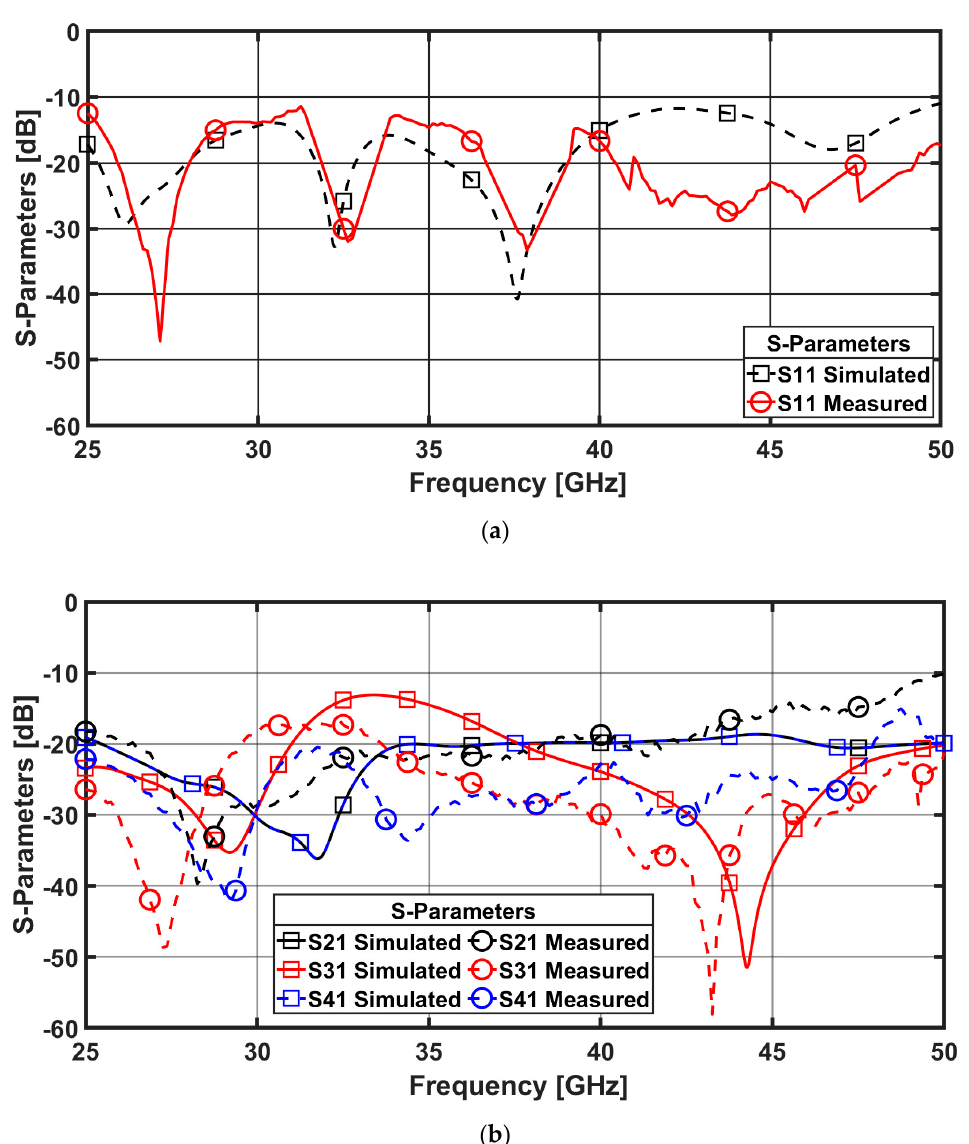
Figure 6. S-parameters coefficient ( a ) Reflection coefficient ( b ) Transmission coefficient